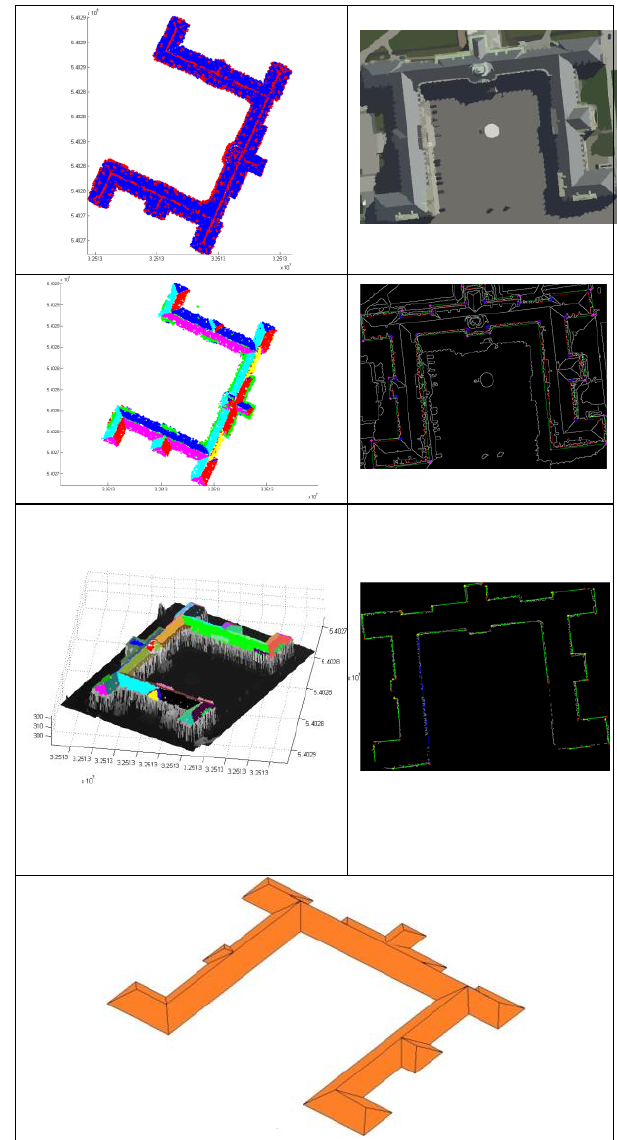
Figure 9. 3D building roof